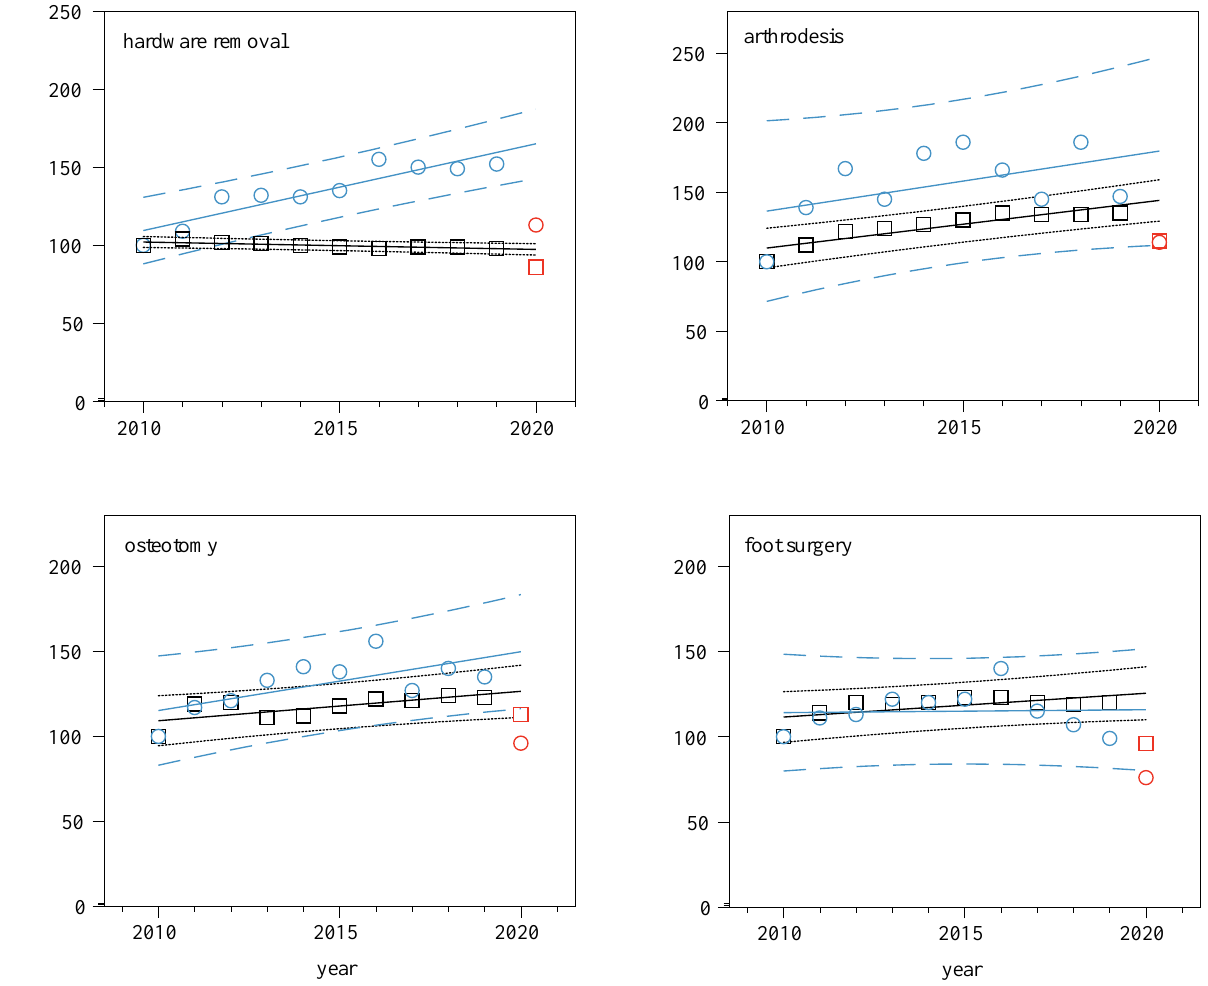
Figure 1. Relative change for each orthopedic procedure for the years 2010 – 2020. The relative count for each surgical procedure (bone biopsy, knee arthroplasty, hardware removal, arthrodesis, osteotomy, and foot surgery) was expressed as a fraction (in %) of each value (per year and group) divided by the corresponding value (per group) for the year 2010. Data for the non-DE group are given in the diagram with blue circles (“ ○ ” ), and data for the DE group are marked with black squares (“ ▢ ”). The straight blue line represents the linear regression of the non -DE group, whereas the straight black line illustrates the linear regression of the DE group. The 95% prediction intervals of each dataset are given as dotted lines (small dotted line for the DE group and big dotted line for the non-DE group). The values for the year of 2020 are displayed in red color. The absolute values can be found in Table